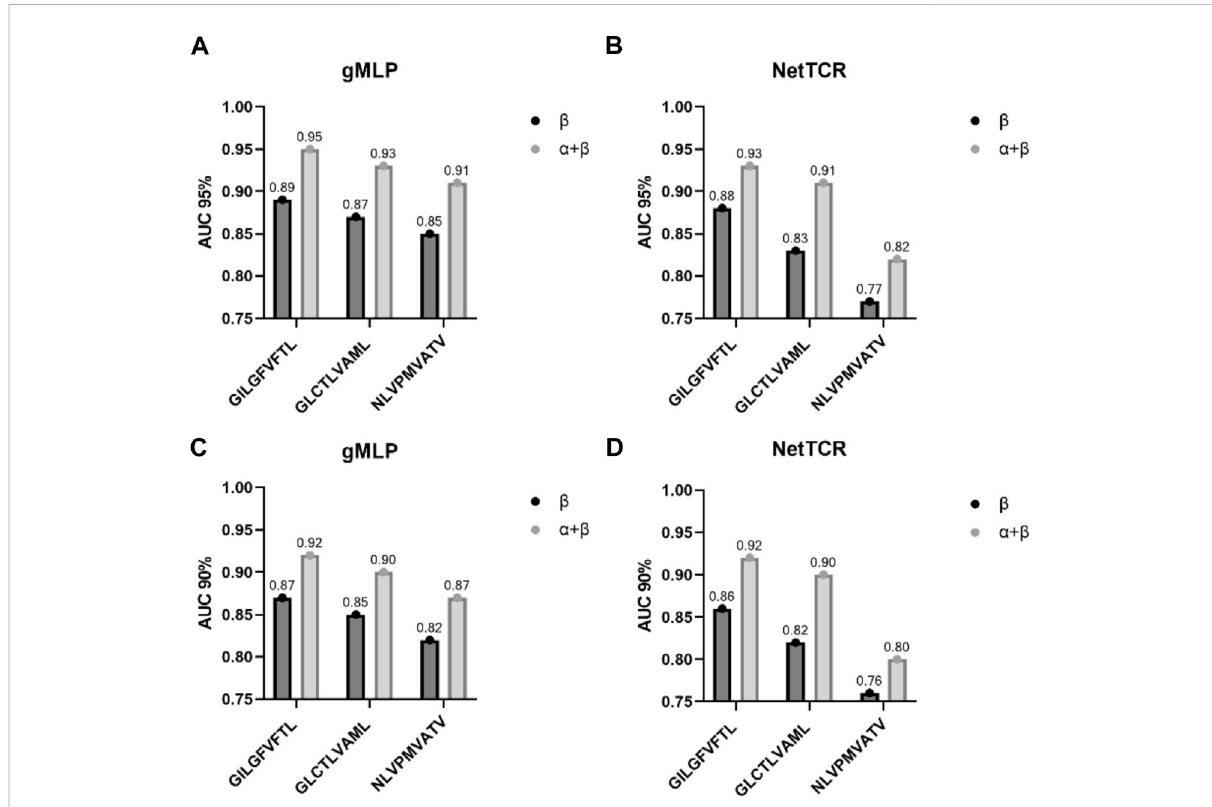
FIGURE 7 AUCfromthethreemostcommonpeptidesinIEDBon90%,95%partitioneddata. (A,B) representtheperformanceofgMLPandNetTCRonthe 90% data. (C,D) represent the performance of gMLP and NetTCR on the 95% data. The partition threshold is based on the similarity between the training and test